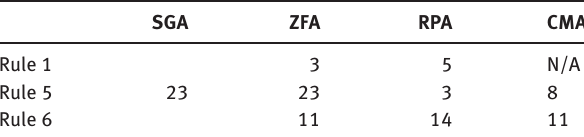
Table 7 Summary of convergence rate (no. of generations).